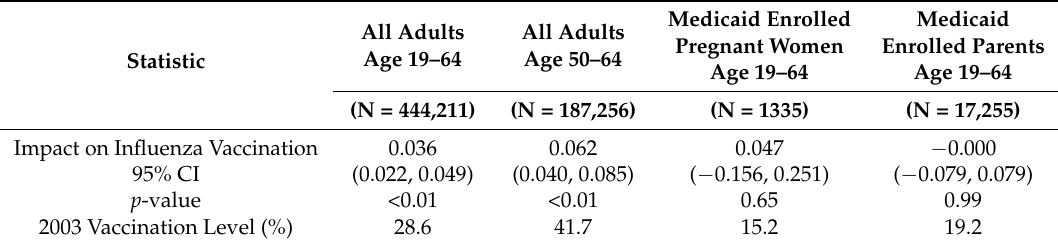
Table 2. Difference-in-difference impacts of covering the influenza vaccine on influenza vaccination coverage for adults, 2003 vs. 2012 BRFSS data.